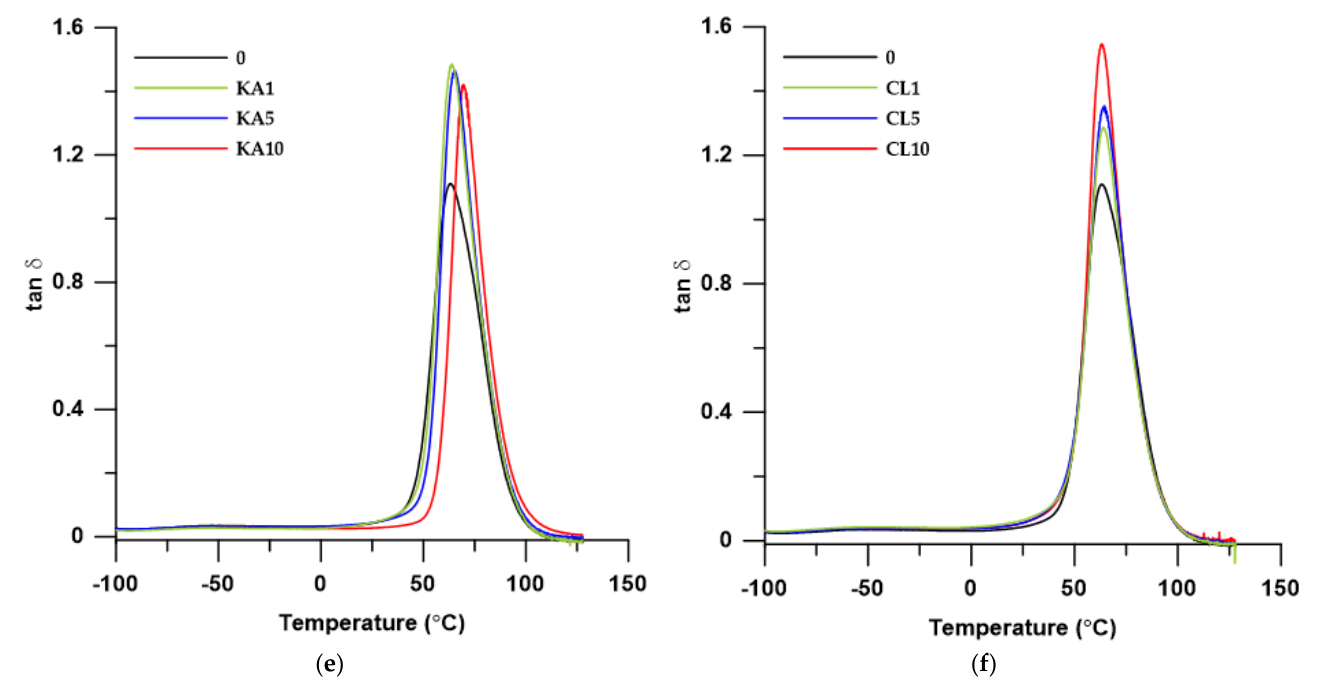
Figure 8. Temperature dependence of storage modulus ( a , b ) loss modulus ( c , d ) and tan δ ( e , f ) of the prepared materials.